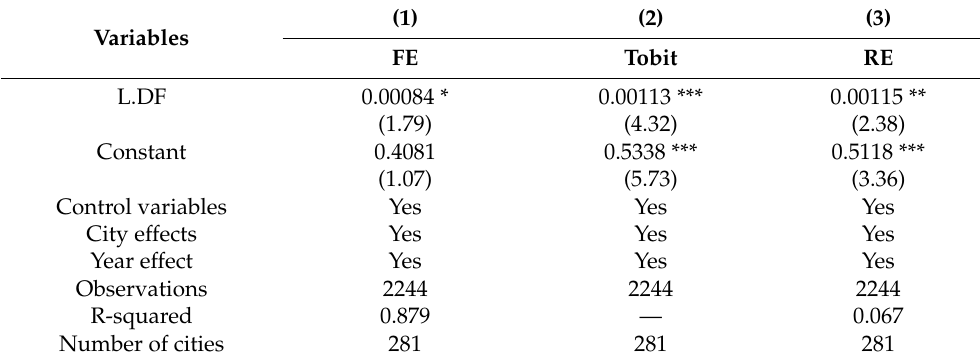
Table 4. The lag effect of DF